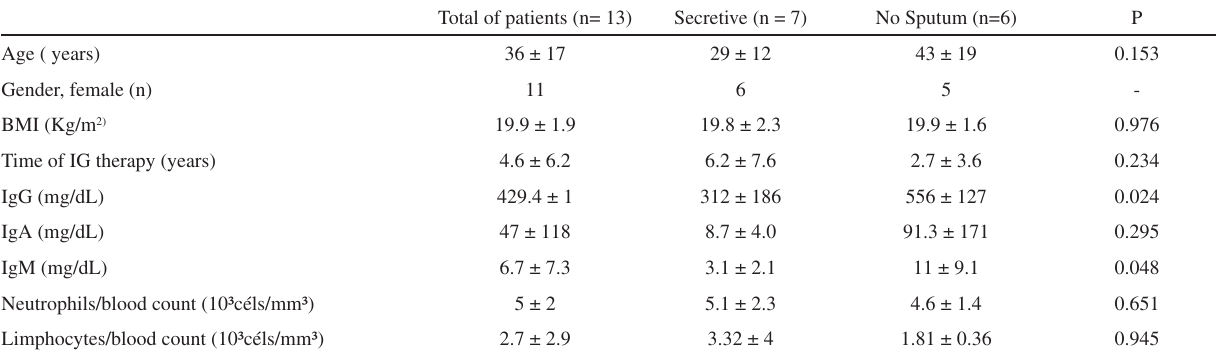
Table 1 - Demographic, clinical (time in IG therapy) and laboratorial characteristics (IG levels and differential leukocyte blood counts) of the 13 patients studied